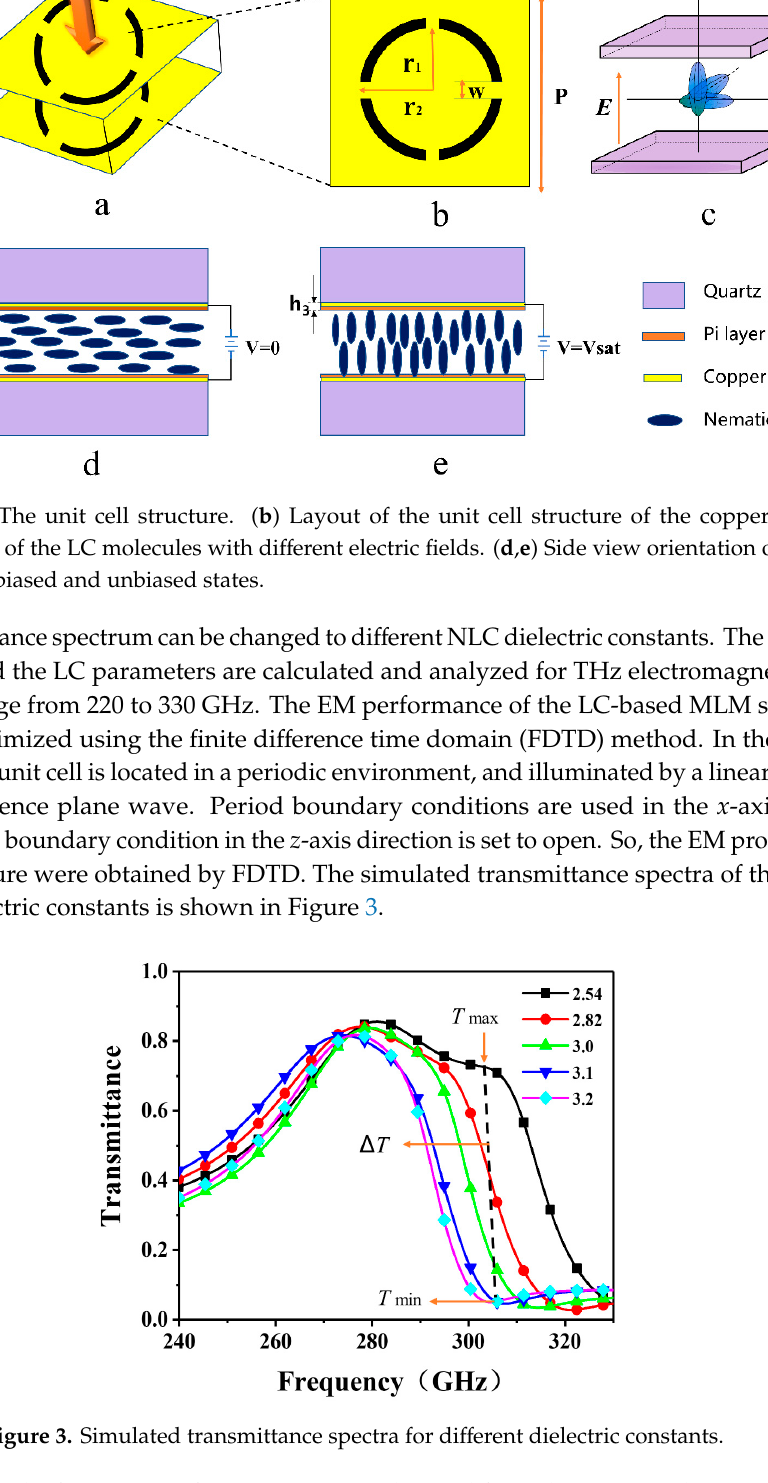
Figure 2. ( a ) The unit cell structure. ( b ) Layout of the unit cell structure of the copper pattern. ( c ) Orientation of the LC molecules with different electric fields. ( d , e ) Side view orientation of the LC molecules for biased and unbiased states.